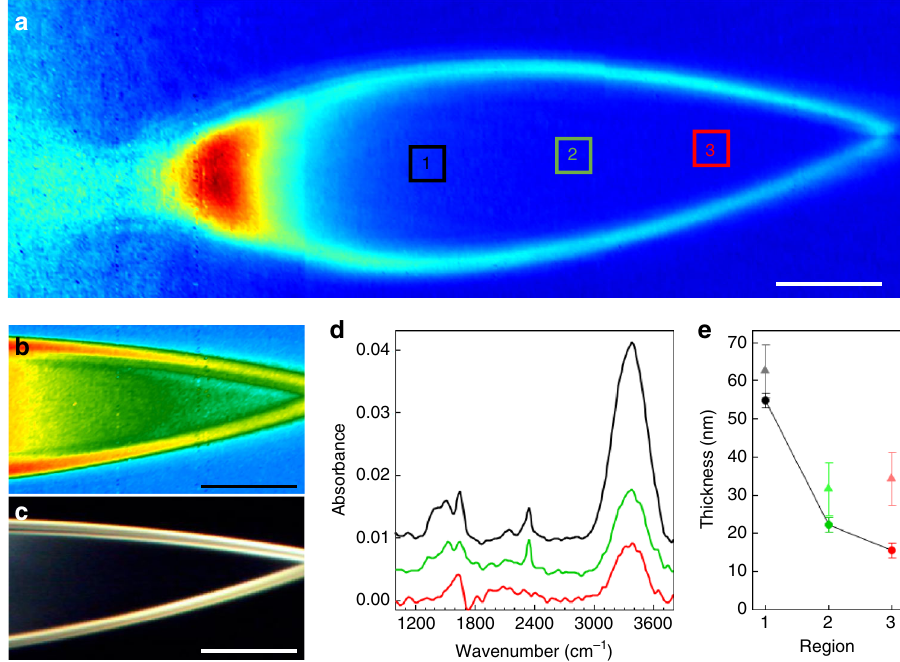
Fig. 5 Infrared spectromicroscopy of ultrathin liquid water sheets. a A false-color image of the integrated IR transmission (3100 – 3650 cm − 1 ) through a water sheet with 150 µ L min − 1 fl ow rate, compiled from three separate tiled images with no additional processing. The color scale for the image in b is the spectral weight in the O – H stretch mode, highlighting the amount of liquid water in the sheet. The corresponding optical re fl ection image is shown in c , demonstrating total lack of re fl ection for the thinnest parts of the sheet. d Infrared absorption spectra of the water sheet in the three regions highlighted by the black, green, and red boxes in a . The spectra for regions 1 and 2 are offset for clarity. e The calculated sheet thickness in each of the three regions indicated in a , using the measured absorbance values of the O – H stretch at 3404 cm − 1 (dark circles, connected by black lines for clarity) and the H 2 O bending mode at 1643.5 cm − 1 (light triangles). The error bars in e represent an estimate of the uncertainty of the absorption measurement based on the signal-to-noise ratio of the peaks of interest. In this case, the error bars are calculated by measuring the baseline noise (peak-to-peak) on either side of the peak of interest and scaling the error for the calculated thickness by standard error propagation methods. The scale bars in all panels are 50 μ